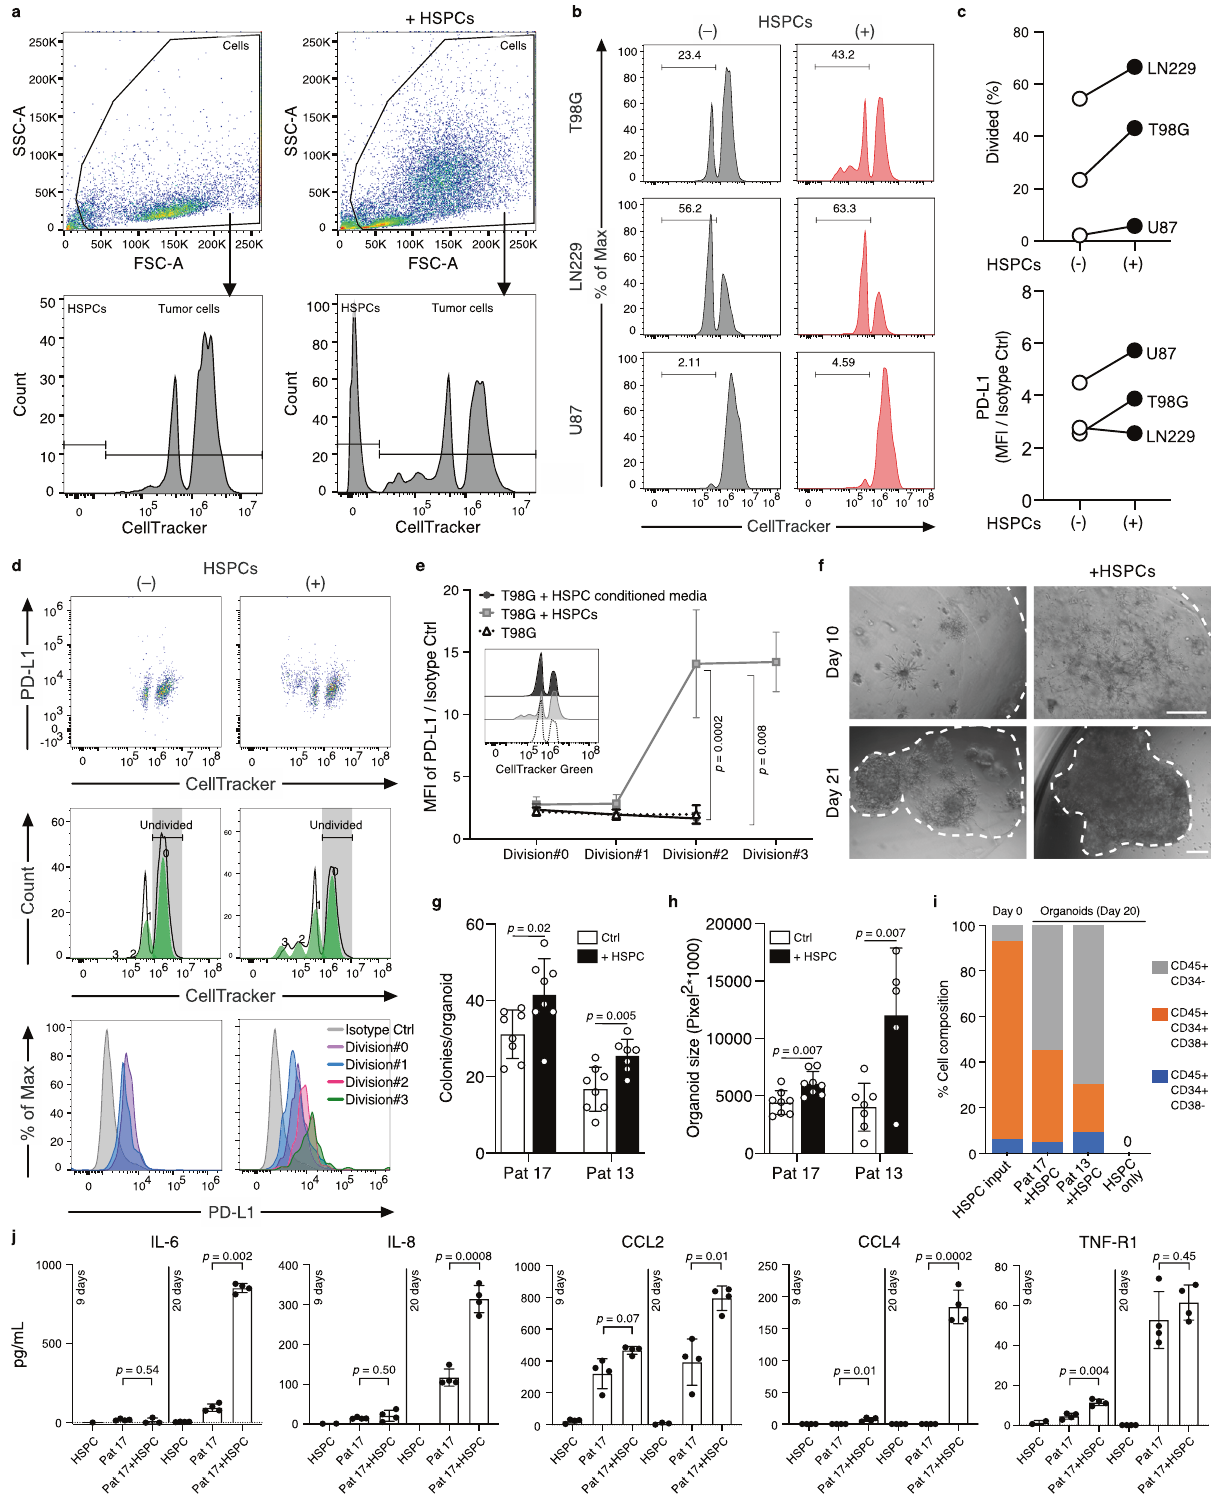
cytokines ( p = 1.4 × 10 − 7 , and p = 9.7 × 10 − 12 respectively, Student ’ s t -test), but not with expression of proin fl ammatory cytokine genes such as IL2 , IFNG , IL12 or IL17 . An exception to this were TNF and IL6 62,70 , which positively associated with the HSC high samples (Fig. 6f and Supplementary Fig. 11a). Furthermore, HSC high glioblastoma samples associated with the expression of immune checkpoint molecules, including PD-1 ( PDCD1 , p = 2.7 × 10 − 4 ), PD-L1 ( CD274 ,